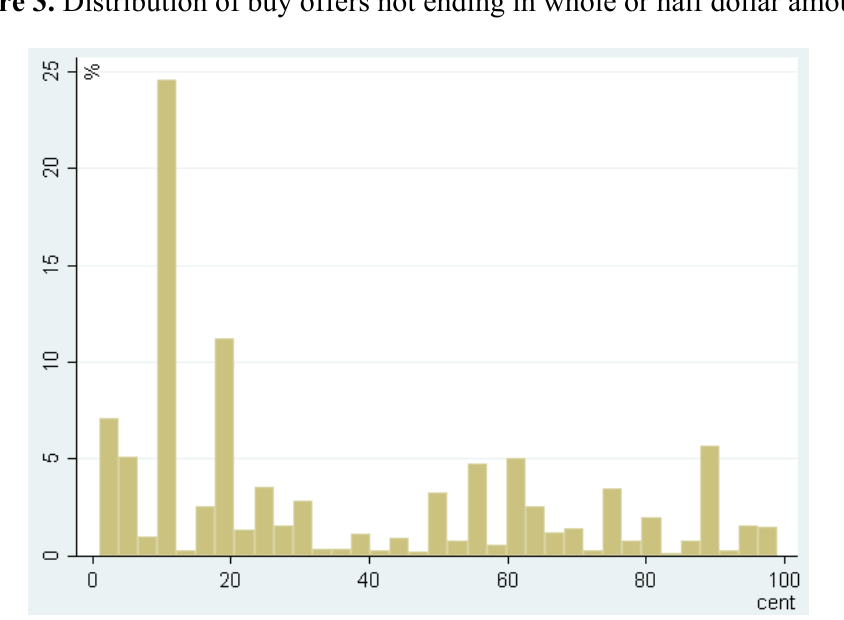
Figure 3. Distribution of buy offers not ending in whole or half dollar